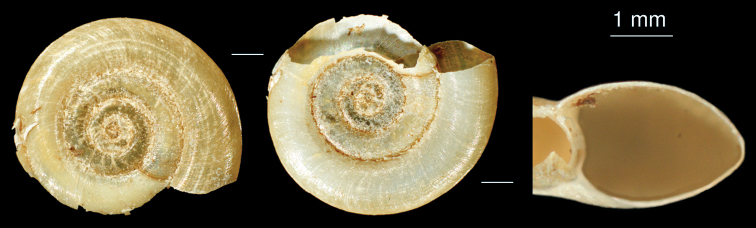
Anisus sp.: shell.